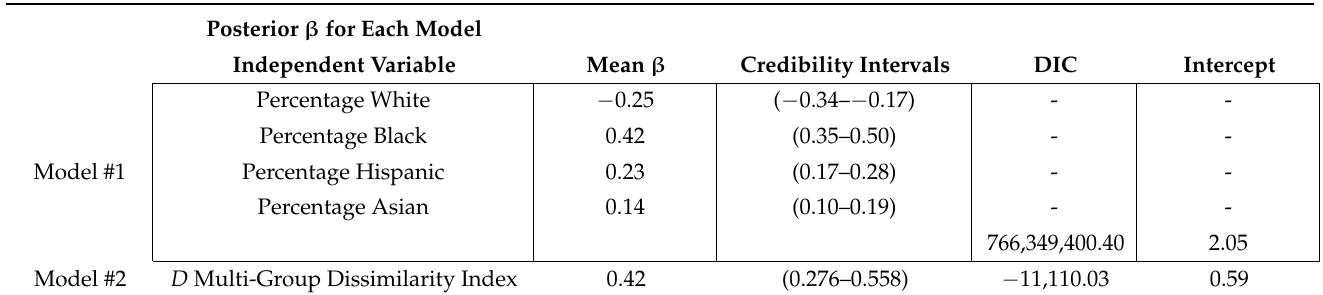
Table 5. Bayesian hierarchical spatial temporal ecological regression values for posterior β , credibility intervals, Deviance Information Criteria (DIC), and intercepts for each model developed in the study.